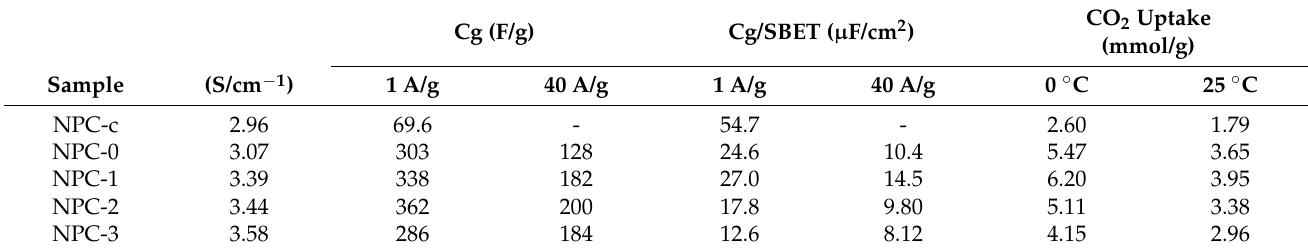
Table 1. Conductivity, electrochemical properties, and CO 2 uptakes at 1 bar of NPCs [95].